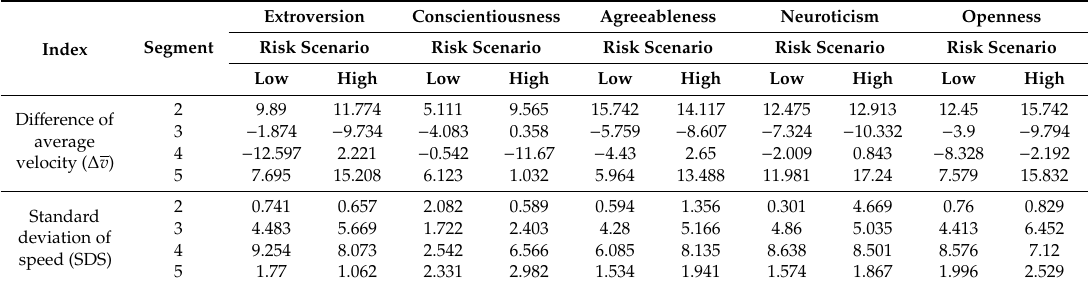
Figure 9. Comparison of SDS for the five types of personality in risky scenarios. Table 5. Values of driving indexes in each segment for high- and low-risk driving scenarios.